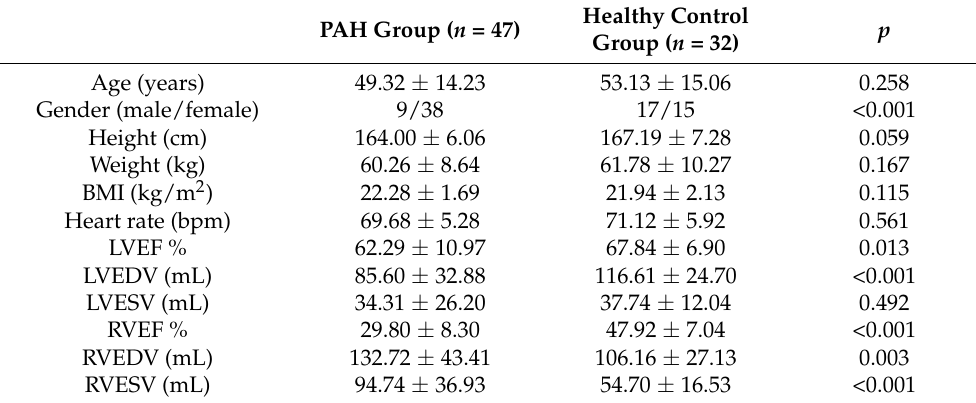
Table 1. Baseline clinical characteristics and cardiac function parameters in the PAH and healthy control